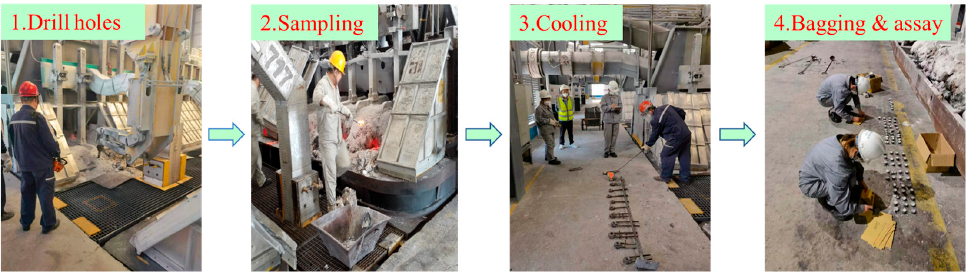
Figure 9. The collection process of electrolyte.